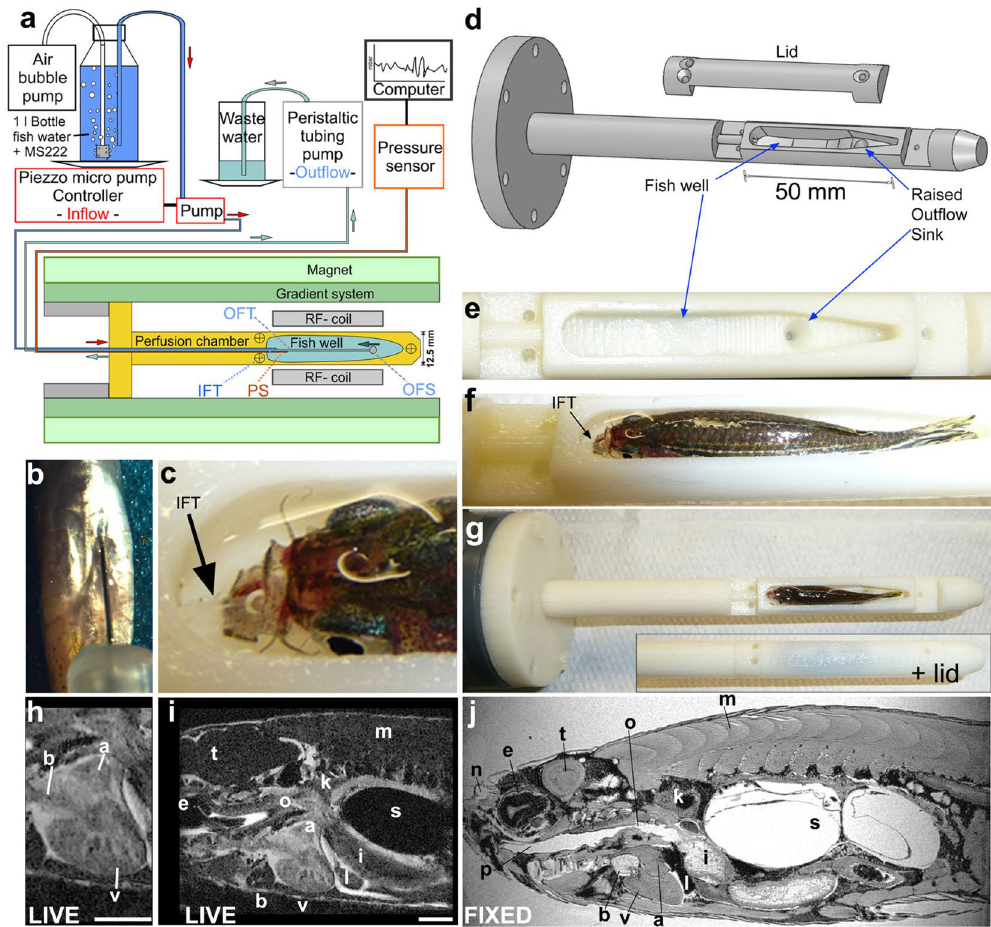
Figure 2. Respiratory and anaesthesia perfusion set-up for adult zebrafish in vivo imaging. (a) Schematic drawing of the perfusion system and MRI set-up. IFT – inflow tube, OFS – outflow sink, OFT – outflow tube, PS - pressure sensor (b) Ventral view (anterior at the top) of a zebrafish showing an intra-peritoneal injection of contrast agent prior to MRI. (c) Photograph showing the thin transparent respiratory perfusion inflow tube (IFT, arrow) positioned in the zebrafish mouth. Note the water level is above the eyes of the fish and covers the gills. (d) Drawing of the fish perfusion chamber as used for 3D printing illustrating the contours of the fish well. (e) Empty fish well of the perfusion chamber (view from top) with the outflow sink visible. (f) Fish well containing an adult zebrafish with perfusion inflow tube (IFT, arrow) in its mouth ready for imaging (see also c). Note the fish is 2/3 covered with water and eyes and gills are submerged. (g) Whole perfusion chamber (top view) containing a fish with and without the lid. The perfusion chamber is screwed onto a larger tube (dark grey) to insert it into the MR magnet. (h–i) Single image plane of a 3D image stack of a live adult zebrafish heart (h) or the whole scan field (i) from eye to mid swim bladder in (sagittal view). Scale bar 1mm. (j) Single image plane of a 3D image stack of a paraformaldehyde-fixed adult zebrafish in sagittal view. a-atrium, b-bulbus arteriosus, e-eye, i-intestine, k-kidney, l-liver, m-muscle, n-olfactory pit, o-oesophagus, p-pharynx, s-swim bladder, t-tectum opticum,